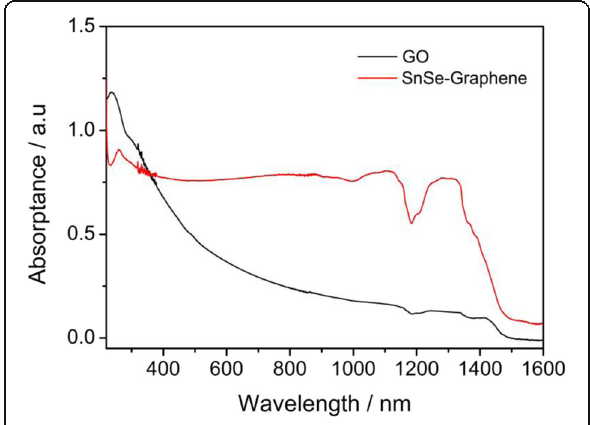
Fig. 5 UV-vis absorption spectra of GO and the